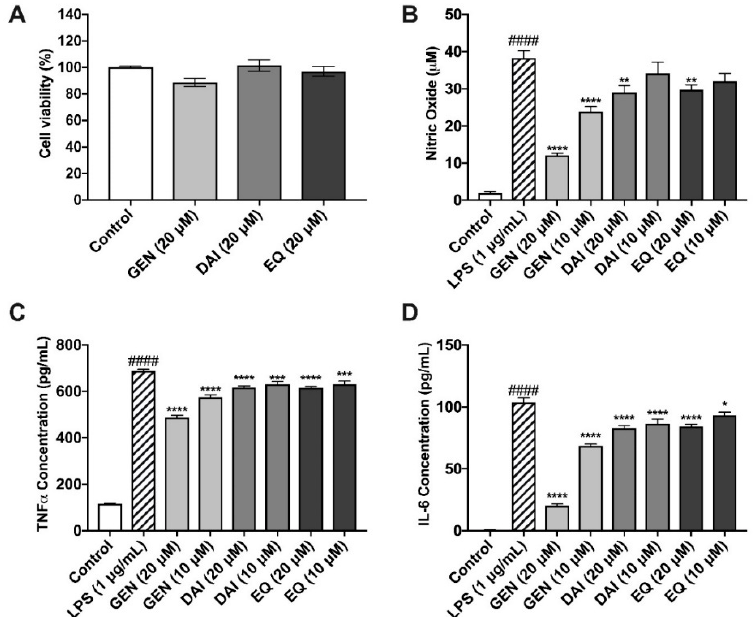
Figure 4. Effects of isoflavones against LPS-induced oxidative stress in BV-2 murine microglia. Isoflavones exhibited no cytotoxic effects in murine microglia ( A ). Isoflavones (20 μ M and 10 μ M) reduce nitric oxide production, as determined by the Griess Reagent ( B ). Isoflavones inhibited the production of the pro-inflammatory cytokines, TNF- α ( C ) and IL-6 ( D ), in murine microglia. All data expressed as mean ± standard error (n ≥ 3), significance was reported by analysis of variance (ANOVA) followed with Dunnett multiple comparison testing. Significance as compared with control p ≤ 0.0001 (####); as compared with LPS, p ≤ 0.03 (*), p ≤ 0.002 (**), p ≤ 0.0002 (***) and p ≤ 0.0001 (****).